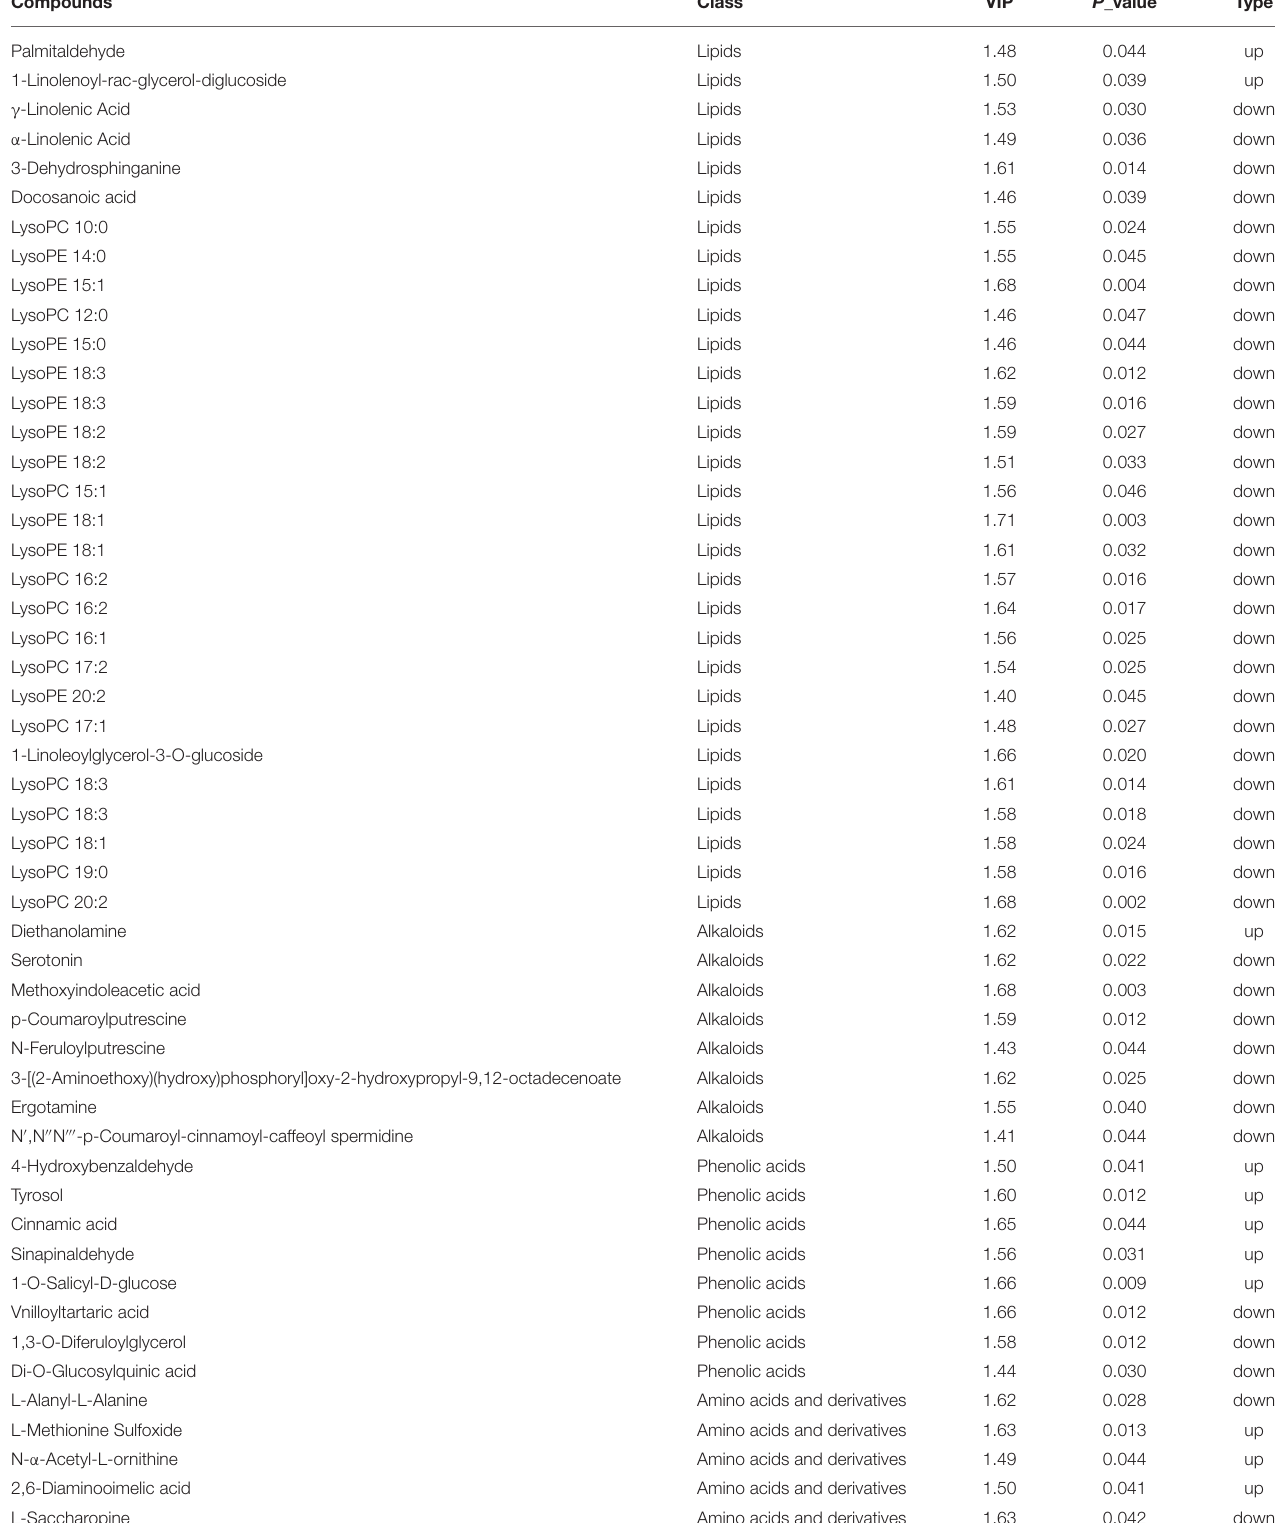
TABLE 3 | Differentially accumulating metabolites in AWD vs. CF comparison. Compounds Class VIP P _value Type Palmitaldehyde